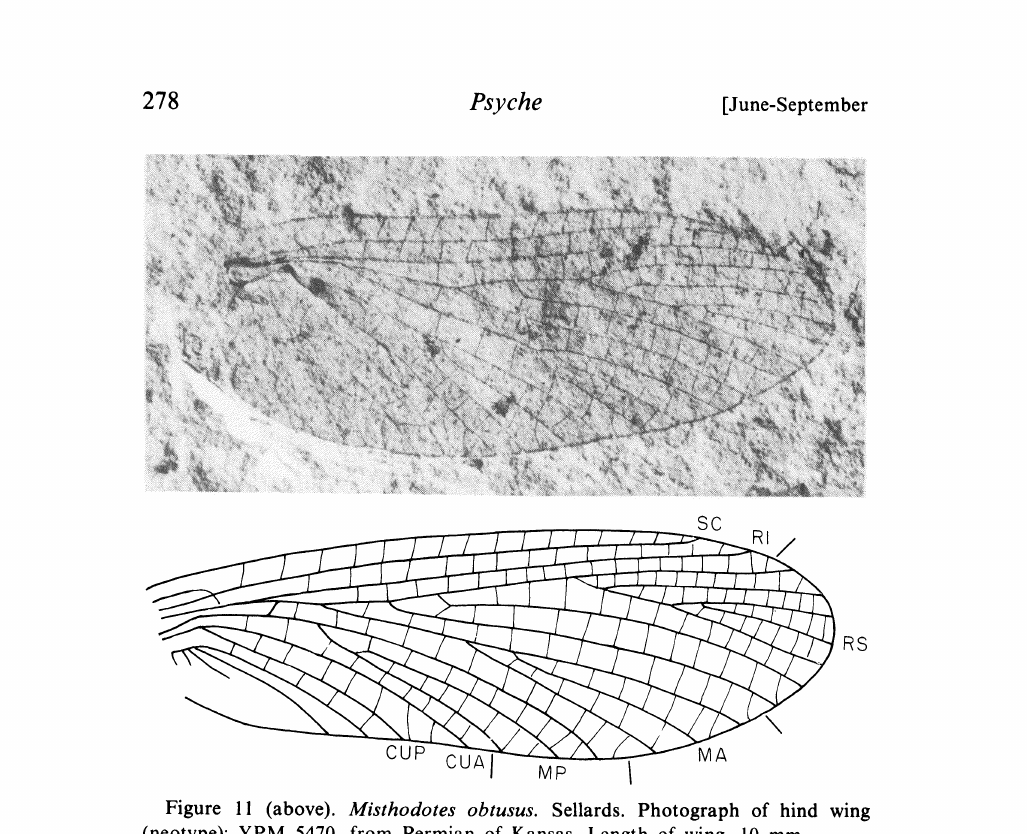
Figure 11 (above). Misthodotes obtusus. Sellards. Photograph of hind wing (neotype): YPM 5470, from Permian of Kansas. Length of wing, l0 mm. Figure 12 (below). Misthodotes obtusus Sellards. Drawing of fore wing, based on MCZ 4386ab, from Permian of Kansas. Length of wing, l0 mm. Lettering as in figure